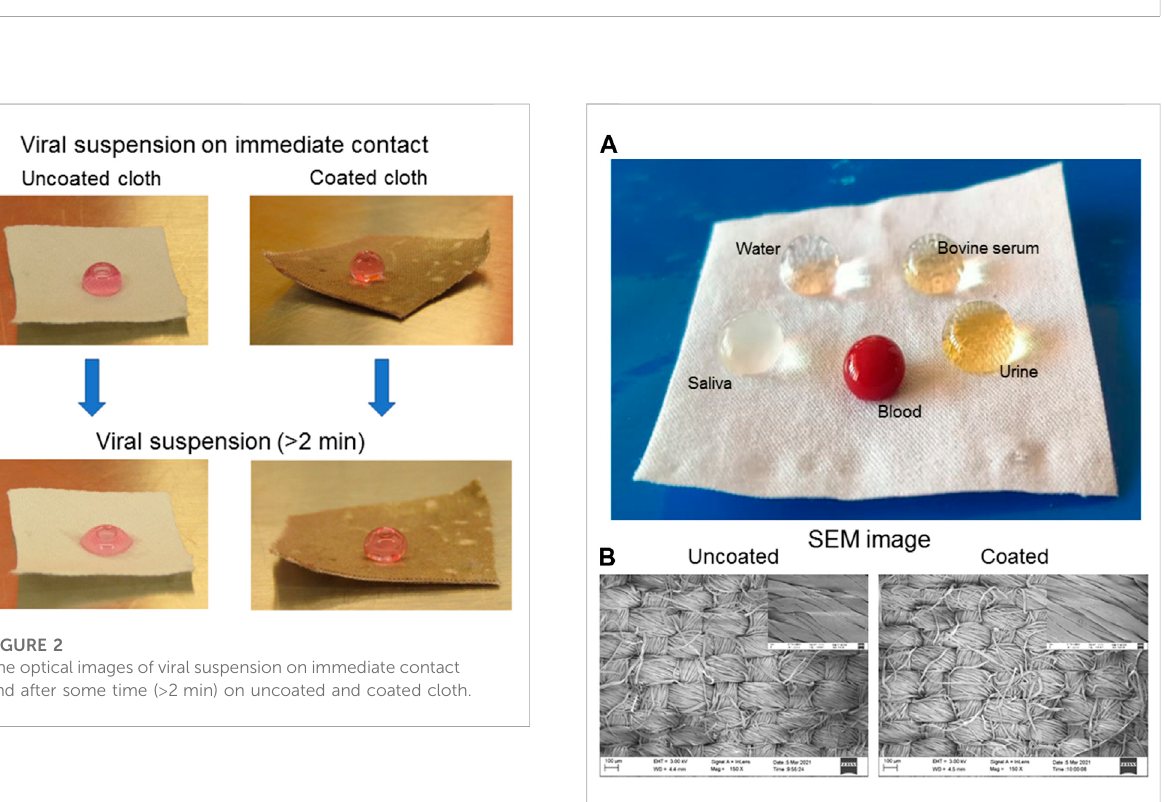
FIGURE 3 (A) Optical image of coated cloth surface containing blood, urine, bovine serum, saliva, and water droplets. (B) SEM images of uncoated and coated cloth. Right corner SEM images corresponding to the high magni fi